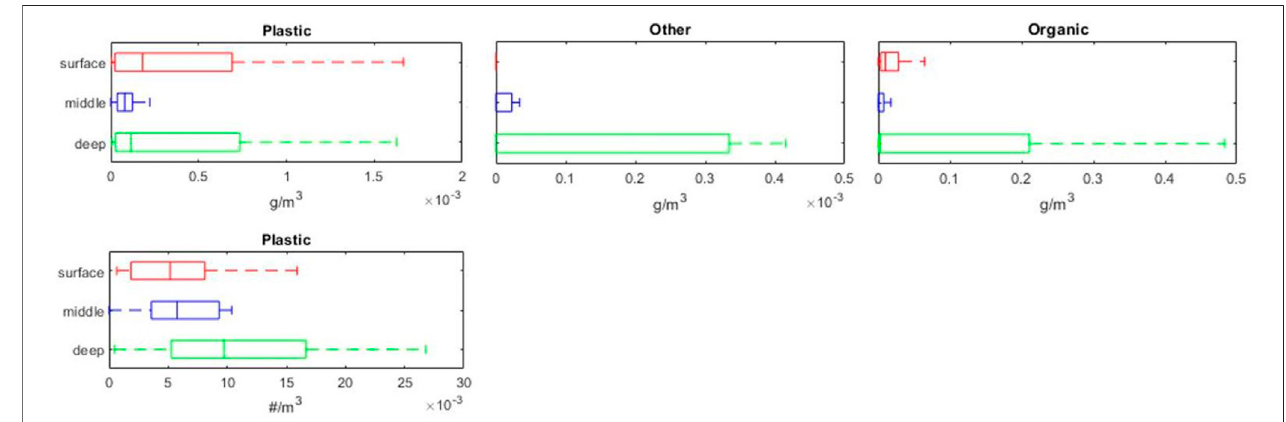
FIGURE 4 | The mass concentration at the three net levels based on all 28 sampling surveys for plastic, organic matter and other materials (A box denotes the 25 – 75%percentile;in thebox themedian isplotted; whiskersgofrom theend oftheinterquartile range tothefurthest observation withinthe whiskerlength). [Lowerleft] Only for plastic litter also the number of items per water volume is